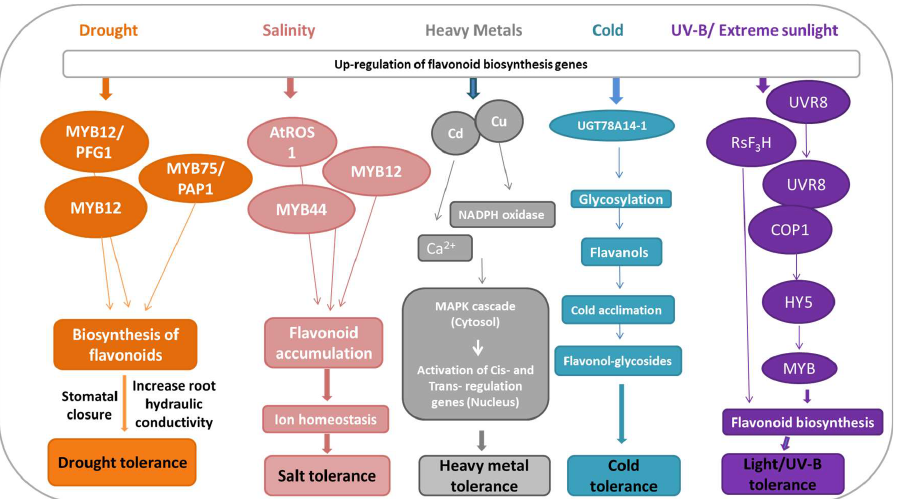
Figure 5. Actions of flavonoids under environmental stress conditions. Following abiotic stress, stress-specific transcription factors are activated and initiate the flavonoids biosynthesis pathway. Flavonoids improve plants’ resilience against abiotic stress by improving root hydraulic conductiv- ity and stomatal movement under drought stress, improving ion homeostasis under salt stress, ac- tivation of cis- and trans-regulation genes in the nucleus under heavy metal stress, and increasing flavanol glycosides under cold stress.